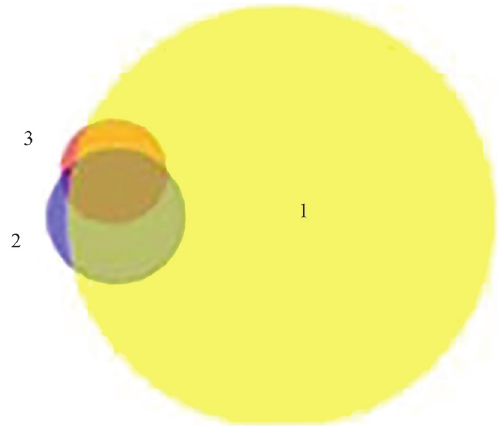
Figure 1 - Venn diagram showing fixed SNPs (MAF = 0) in Uruguayan Creole (1), Merino (2) and Corriedale (3)